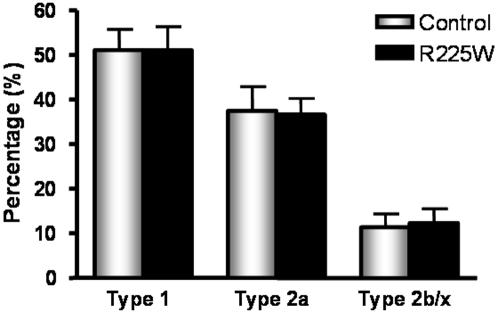
Fiber type ratios of vastus lateralis for R225W versus control subjects, expressed as percentage of each fiber type. Means +/− SD. n = 5, Student's t-test for each fiber type, no significant differences between R225W and control subjects (Type 1: p = 0.992, Type 2a: p = 0.896, Type 2b/x: p = 0.834).